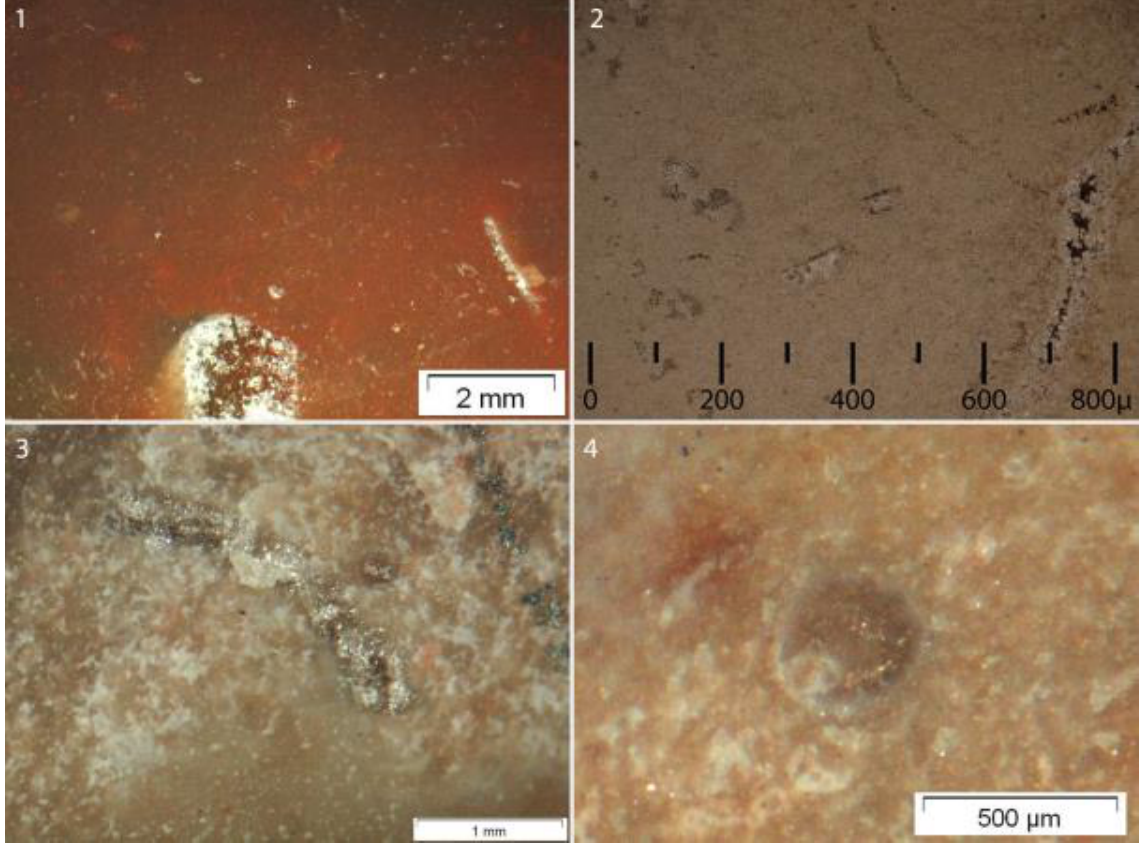
Figure 8. Macro- and microscopic textures and constituents of Cretaceous flints. Note the mudstone texture (1, 2) and bioclastic relicts (3, 4). (Scale bars: 1. 2 mm; 2. 500 µm; 3. 1 mm; 4. 500